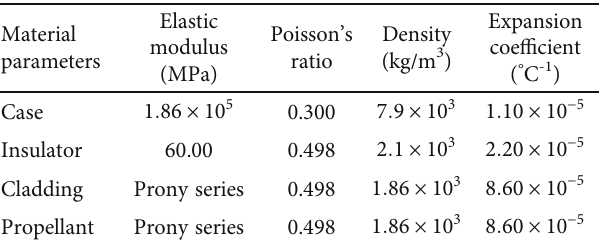
Figure 1: Geometric model of the SRM with star and fi nocyl grain. Table 1: Material parameters of the